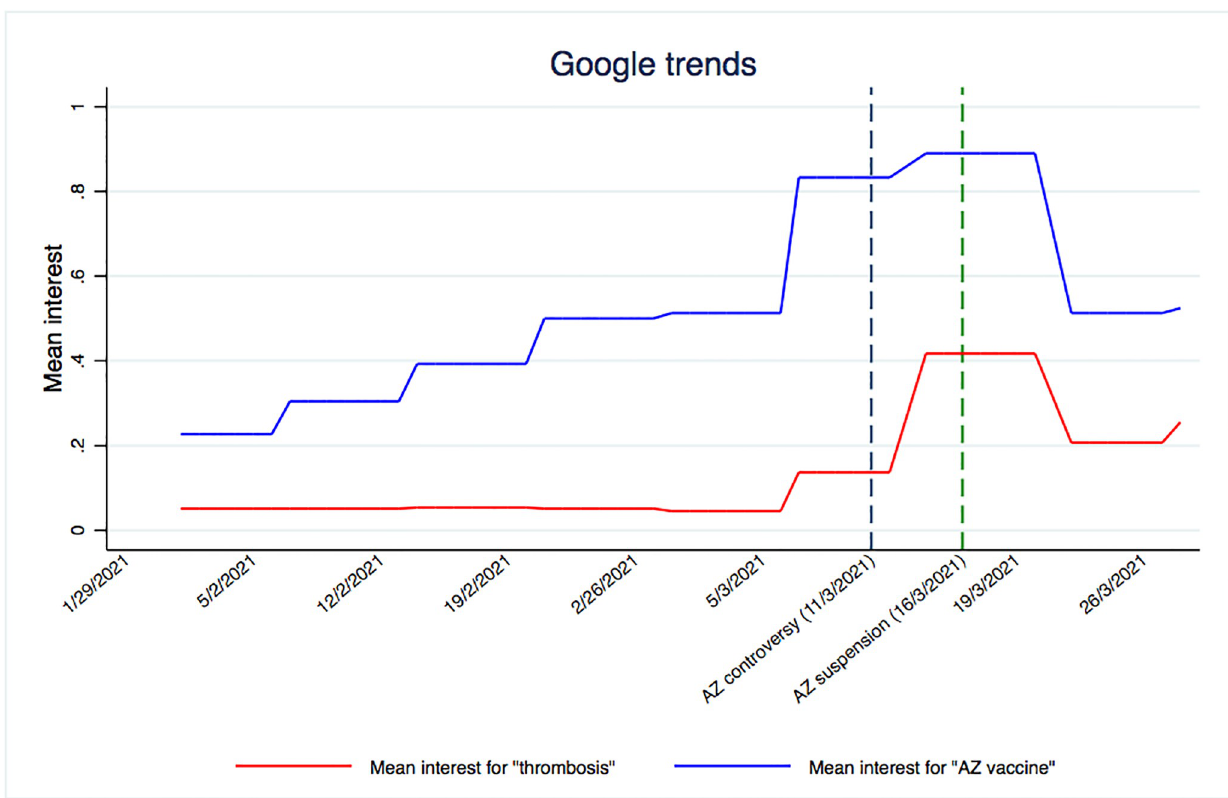
Fig 3. Google trends in the search of “AstraZeneca vaccine” and “thrombosis”. Notes: the graph presents the mean interest for two keywords, "thrombosis" and "AstraZeneca vaccine", during the period from 1 February 2021 to 21 March 2021. Search volumes for these keywords have been retrieved from Google Trends in seven languages: English, French, German, Italian, Spanish, Polisch and